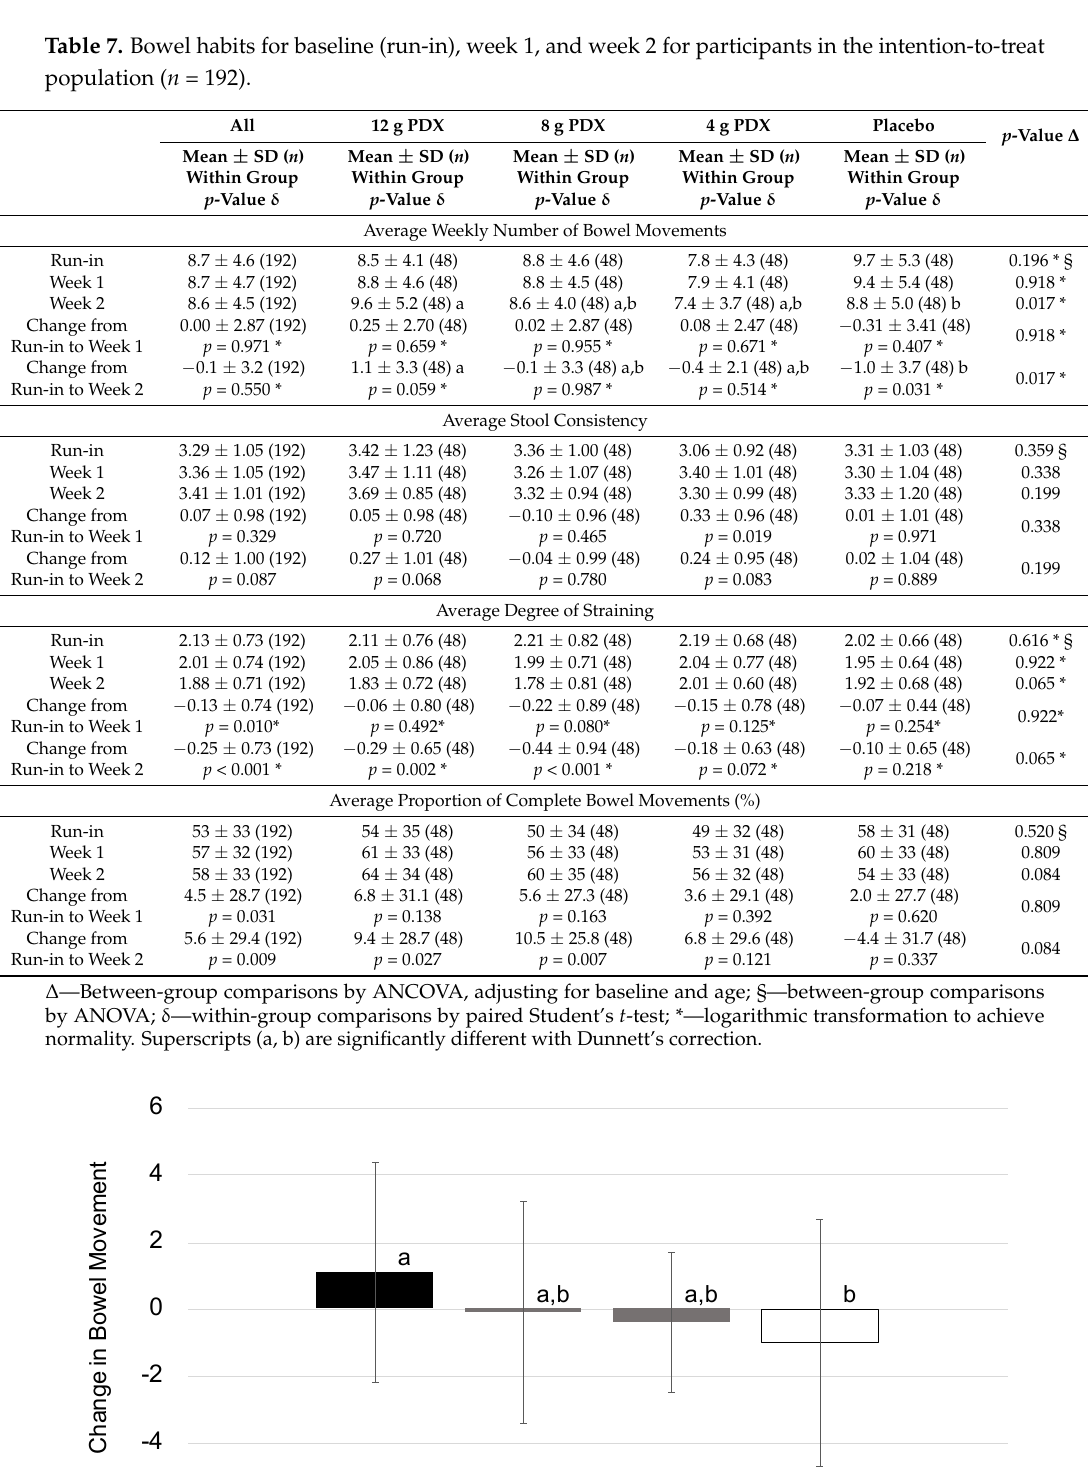
Table 5. Average bowel function index questionnaire results on days 0 and 14 for participants in the intention-to-treat population ( n = 192). All